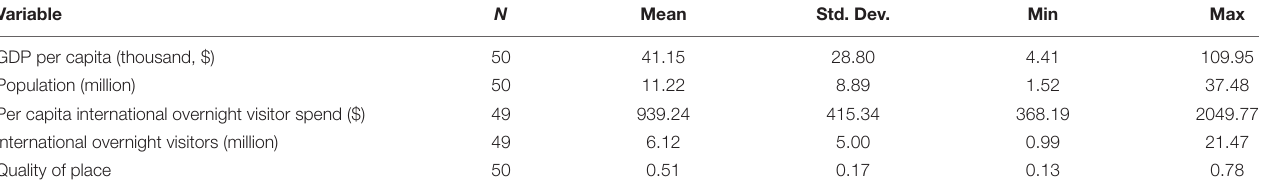
TABLE 2 | Descriptive statistics of